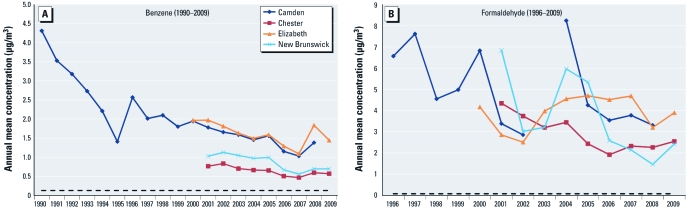
Monitored concentrations of benzene (1990–2009; A) and formaldehyde (1996–2009; B) in four New Jersey cities. Levels of both pollutants have generally decreased over the past several years (NJDEP 2011).